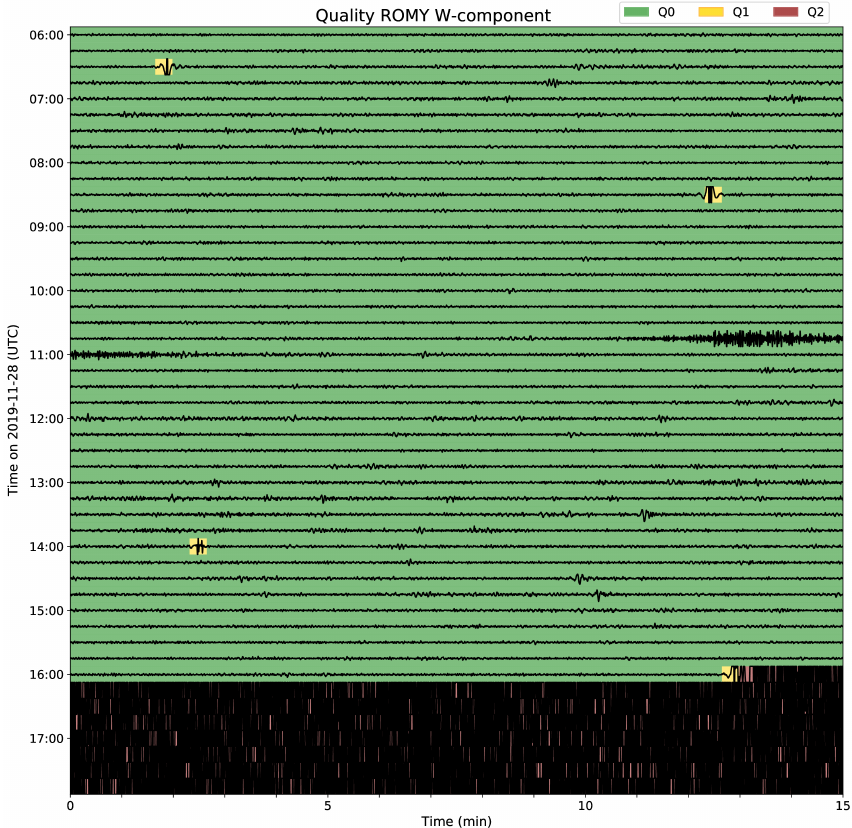
Figure 6. Six hours of data of ROMY’s w-component on 28 November 2019 are shown, including a regional event in Albania (Mw = 4.7) at 10:52:43 UTC. The rotation rate record is mean corrected, bandpass filtered (0.1 to 1.0Hz) and clipped. Background colors indicate assigned quality levels for 20 s